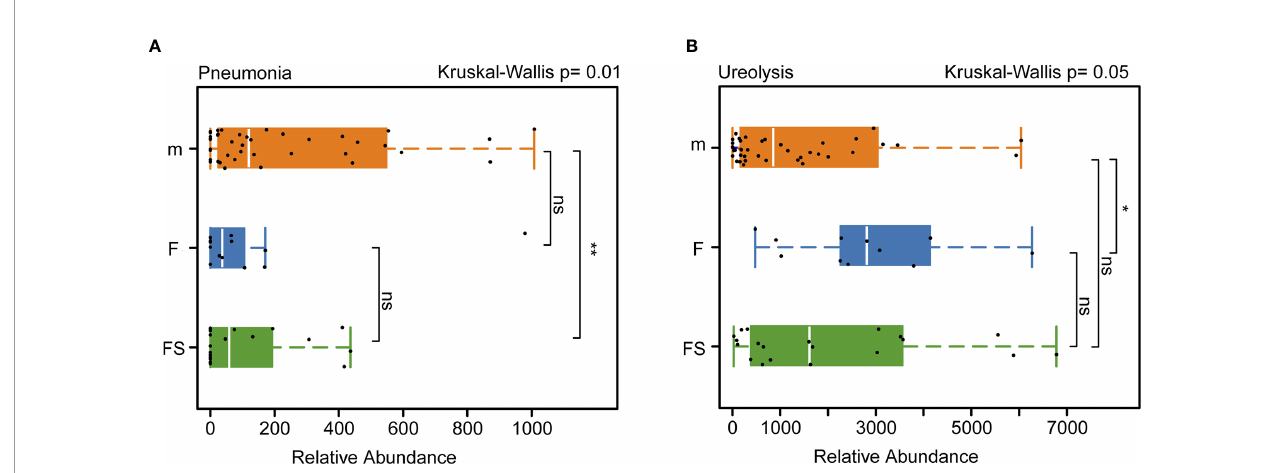
FIGURE 5 | Analysis of the function of intestinal bacteria that affect newborns health. (A) Relative abundance of intestinal bacteria related to septicemia in three groups. (B) Relative abundance of intestinal bacteria related to ureolysis in three groups. fs, supplemented formula group (n = 22); f, standard formula group (n = 13); m, breastfeeding group (n = 48). *(p < 0.05); **(p < 0.01); ns, no signi fi